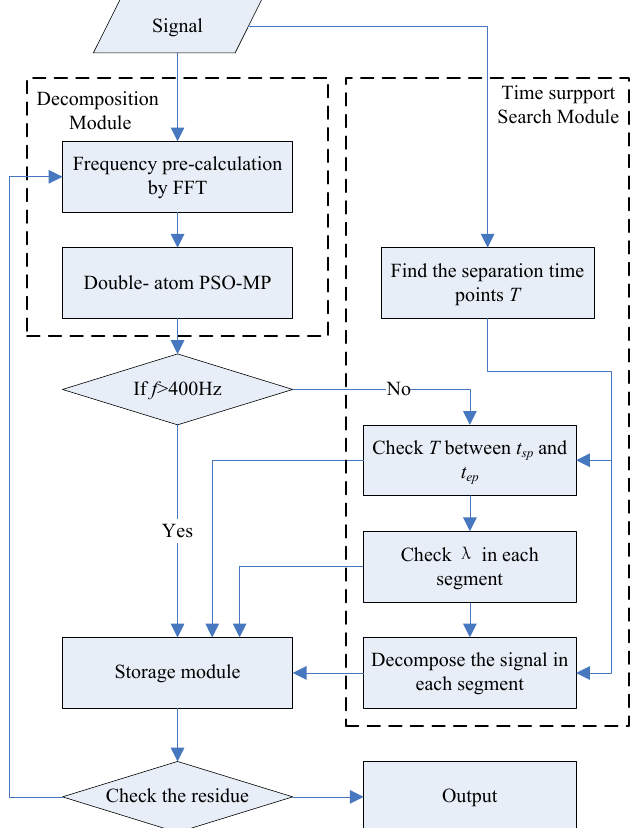
Figure 8. Block diagram of the decomposition